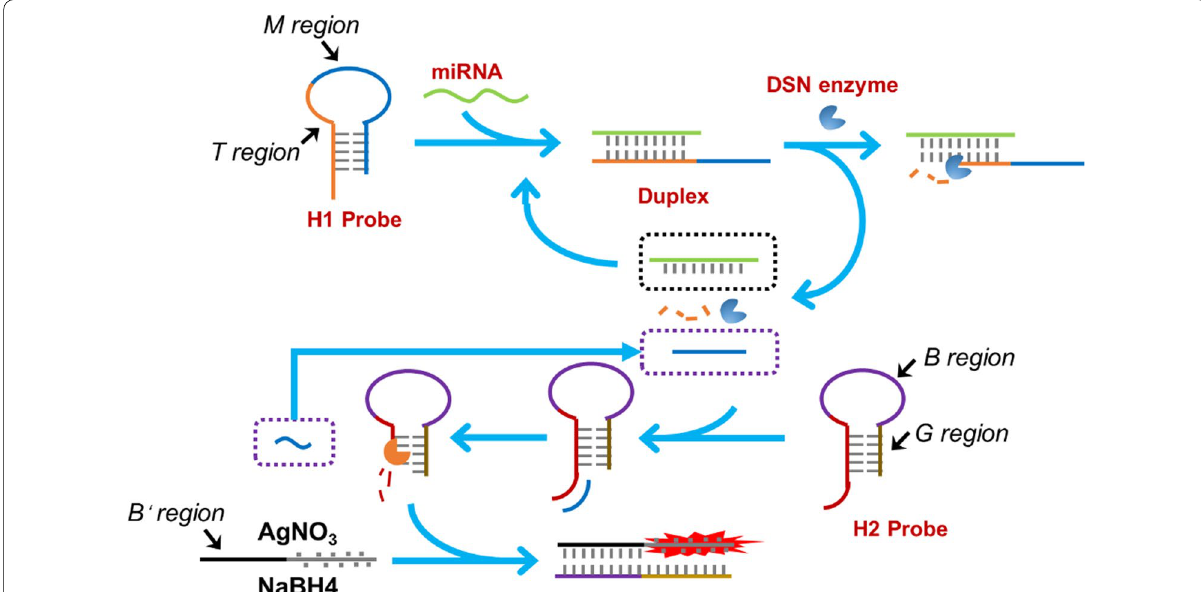
Fig. 1 The working mechanism of the proposed method containing DSN enzyme and Exo-III enzyme-assisted signal amplification and DNA-AgNCs-assisted signal